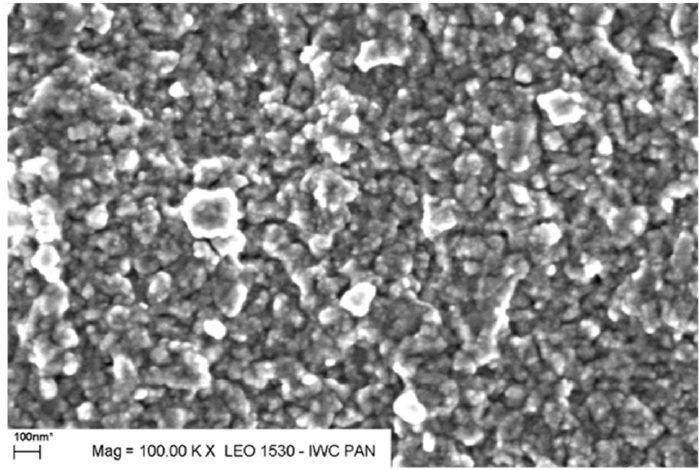
Figure 2. SEM micrograph of a 90 V 2 O 5 · 10P 2 O 5 glassy sample after nanocrystallization at 275 ◦ C (Reproduced with permission from ref. [35]. Copyright 2011,